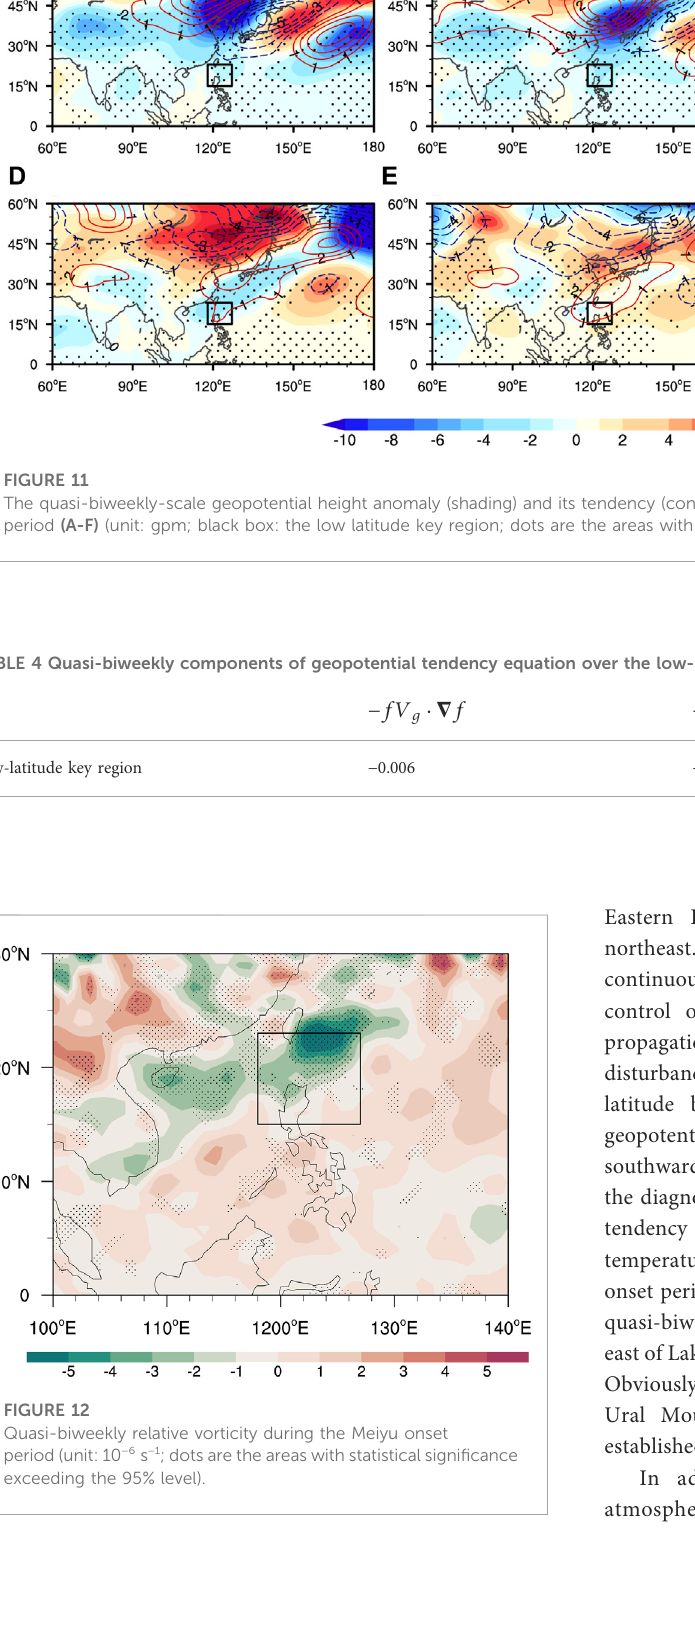
Frontiers in Earth